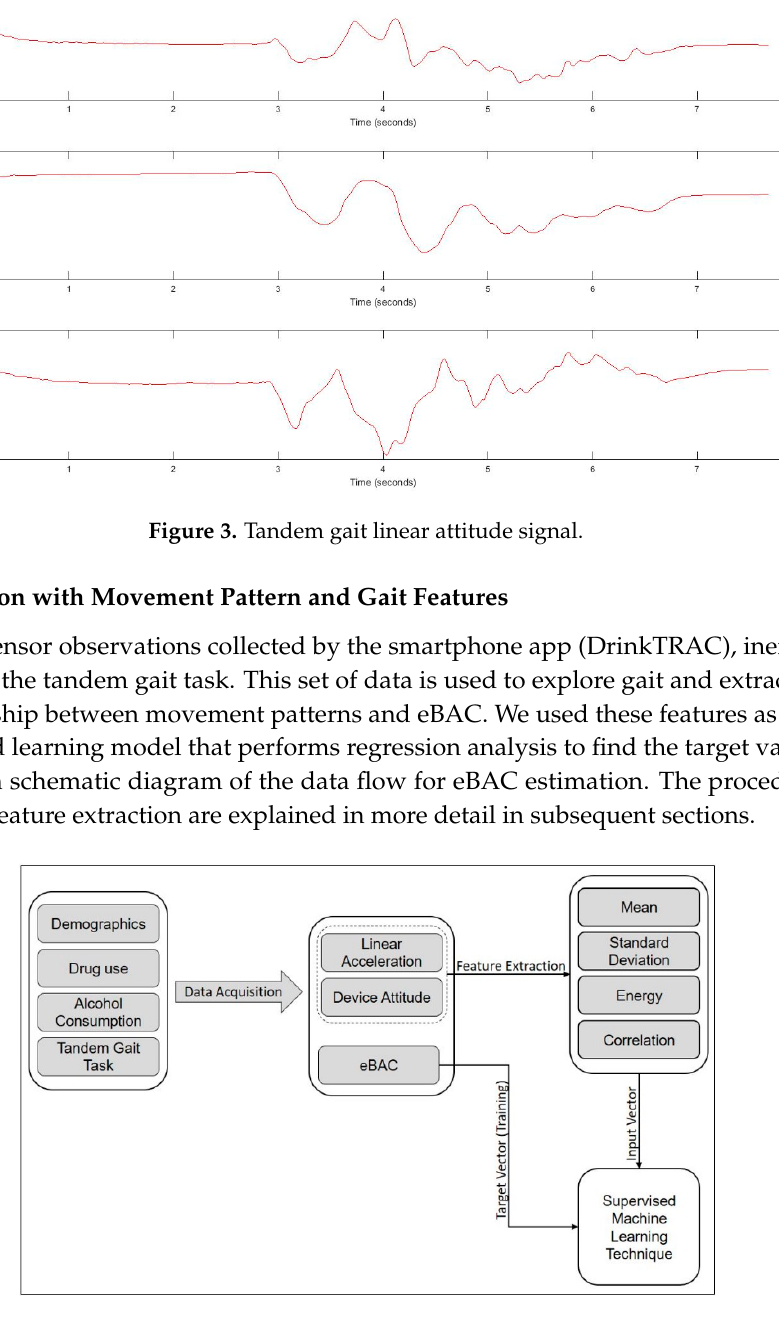
Figure 4. Schematic diagram of the data flow for eBAC estimation.